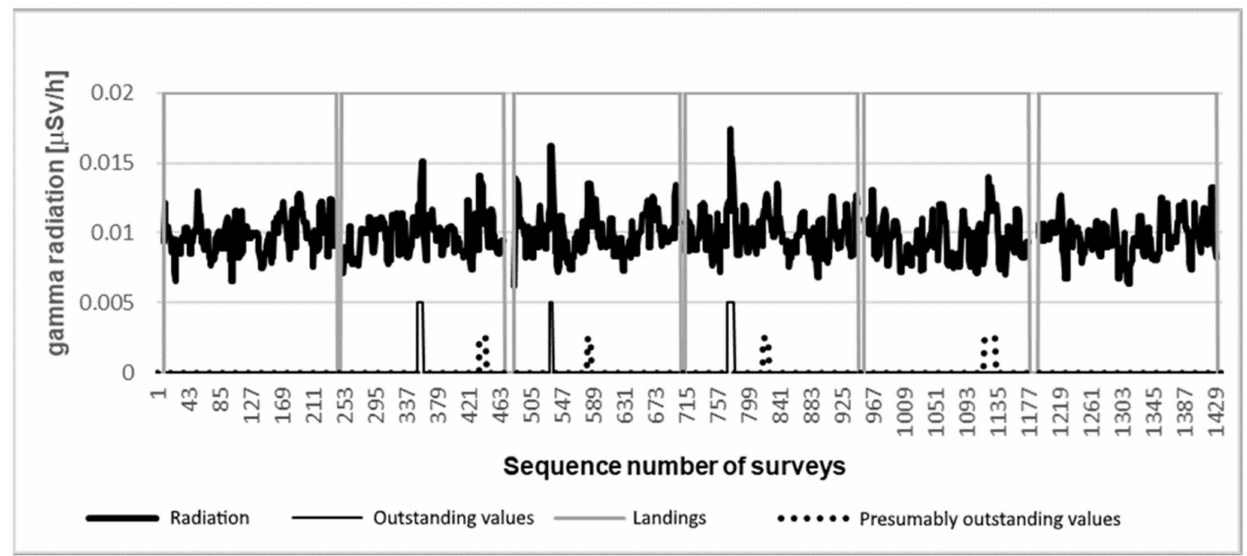
Figure 5. The median filtered data of a radiation measurement over an area of 650 m 2 and the interpretation of given peaks. In Figure 5, the detected radiation data were filtered with a five-element median filter.